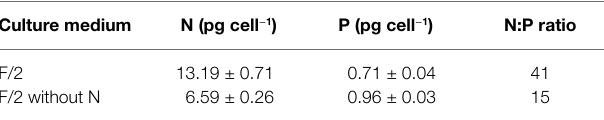
TABLE 2 | The N and P contents (mean of four replicates ± SD) of Rhodomonas salinia cultured in F/2 medium and F/2 medium without N addition, respectively. Culture